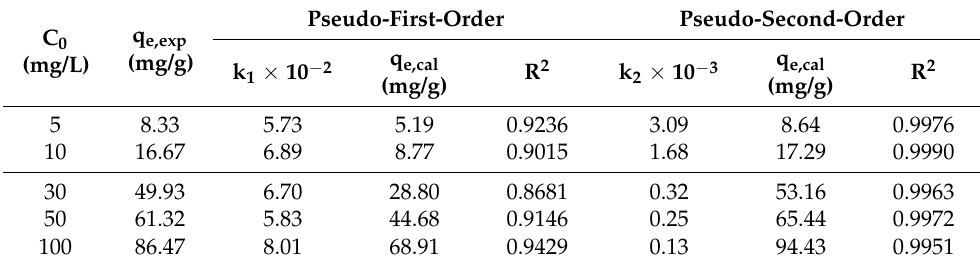
Figure 6. Kinetic curves for phosphate adsorption by Fe 3 O 4 @La(OH) 3 ( A ) pseudo-first-order ( B ) pseudo-second-order model with initial phosphate concentration of 10 mg/L. Table 1. Kinetic parameters for the adsorption of phosphate by Fe 3 O 4 @La(OH) 3 .